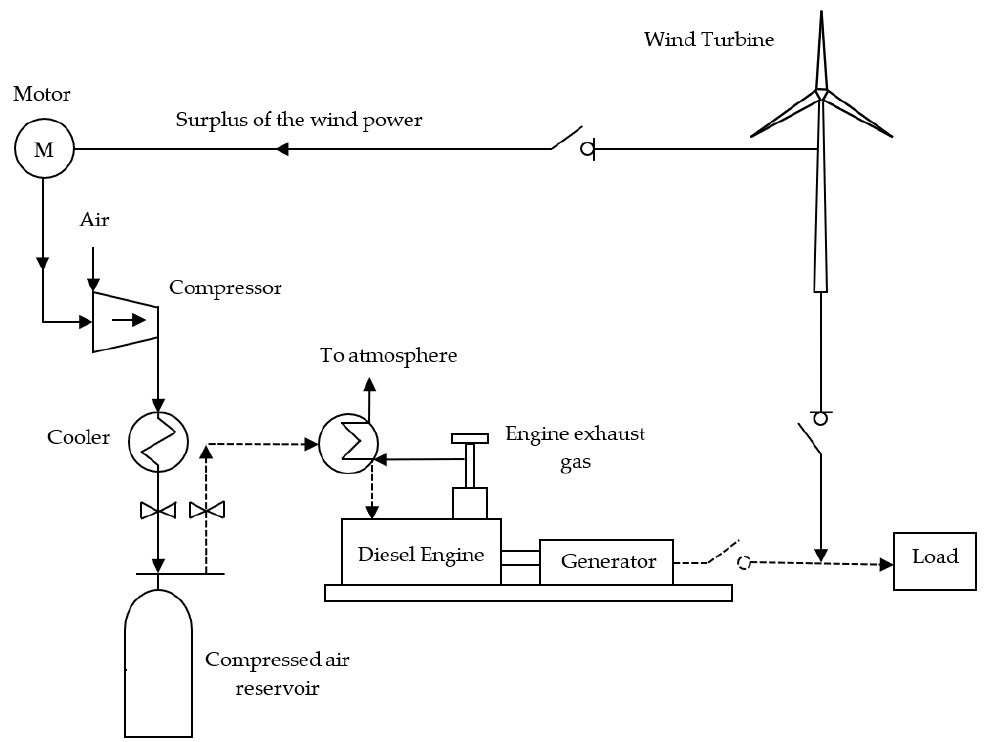
Figure 13. WDHS with a storage system based on compressed air. Adapted from Ref. [17].